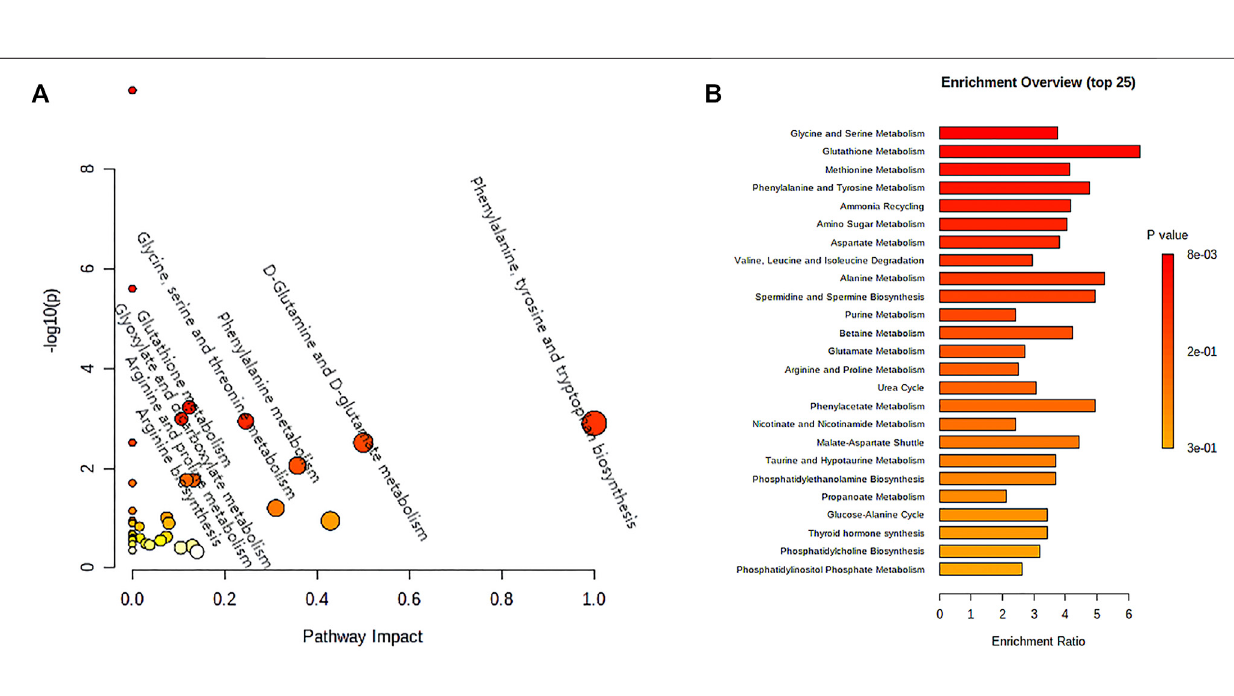
Frontiers in Cell and Developmental Biology |